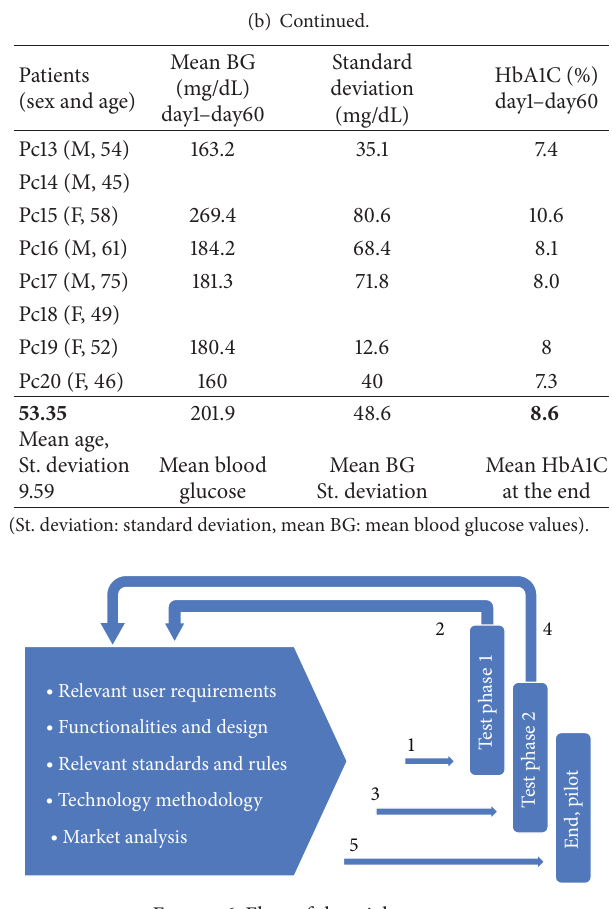
Figure 6: Flow of the trial